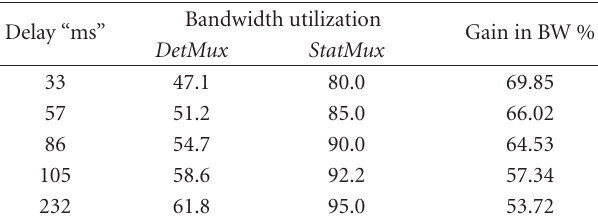
Table 2: Gain of StatMux in di ff erent bu ff ering delays when the bit streams are constrained to a bu ff ering delay of 5 Seconds.